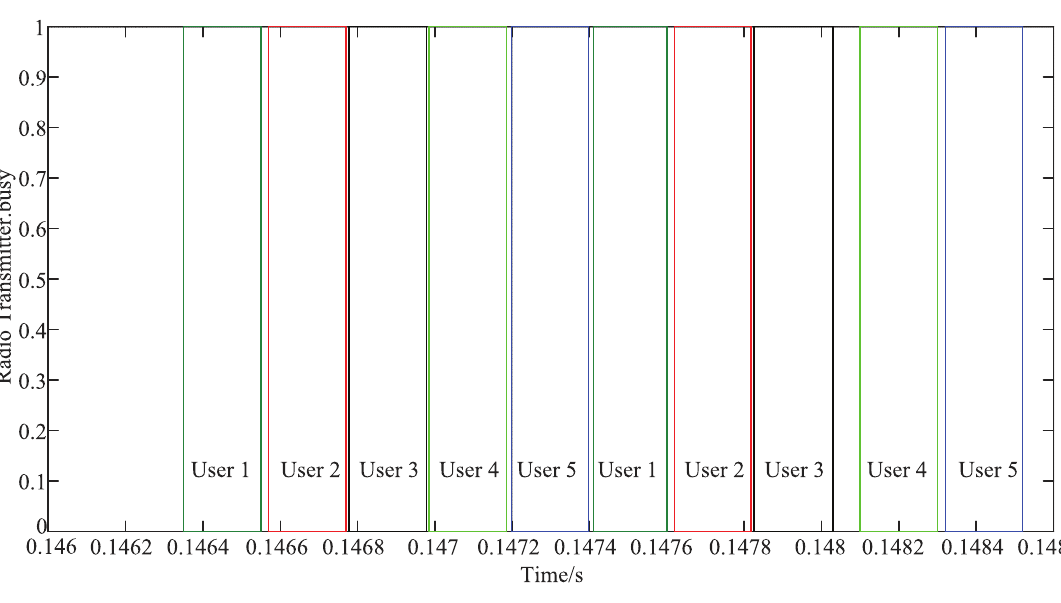
Figure 3. The time slot occupancy of five